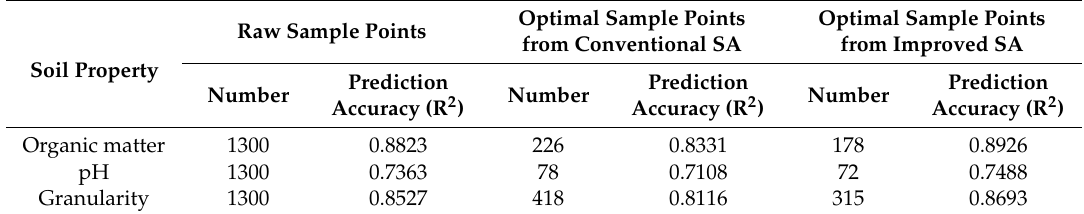
Table 5. Accuracy of predicted soil properties based on sample points that were optimized using the two simulated annealing (SA)